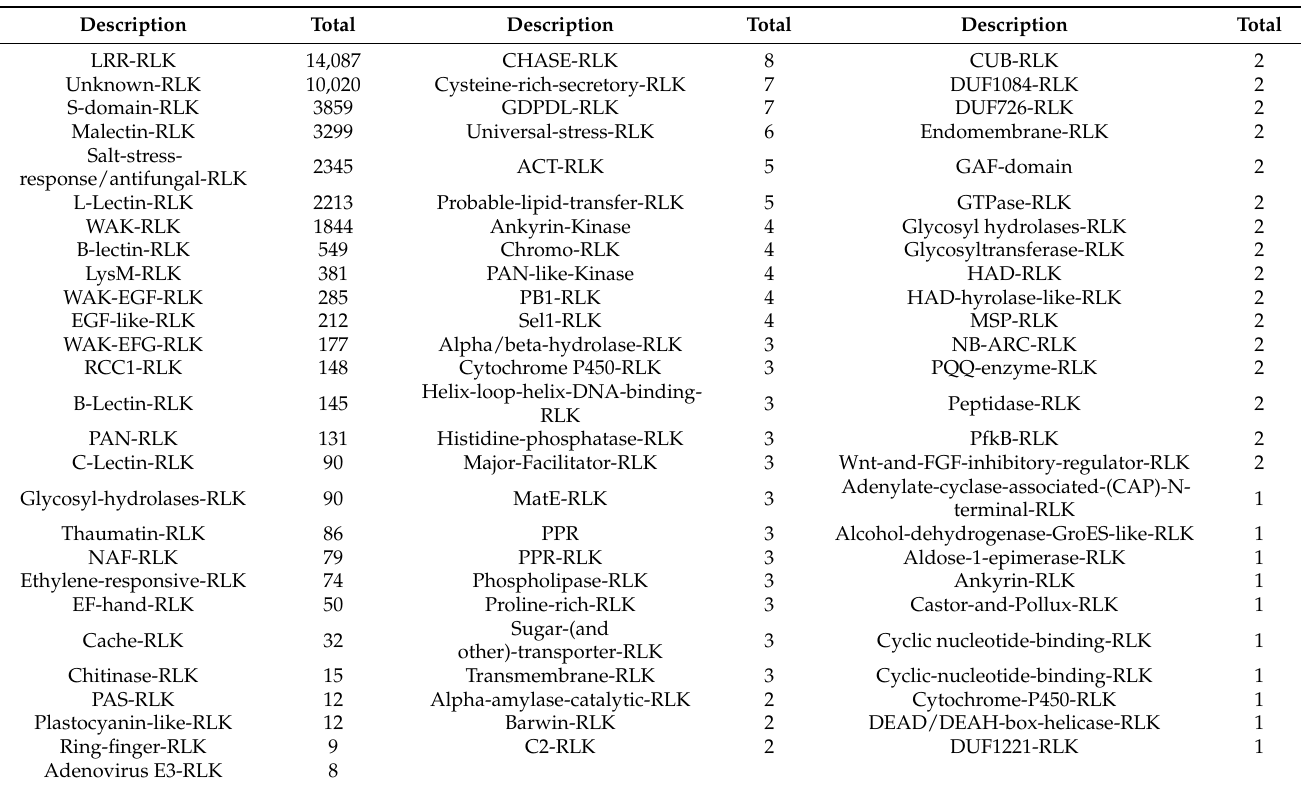
Table 1. Number of RLKs harboring the indicated ectodomain